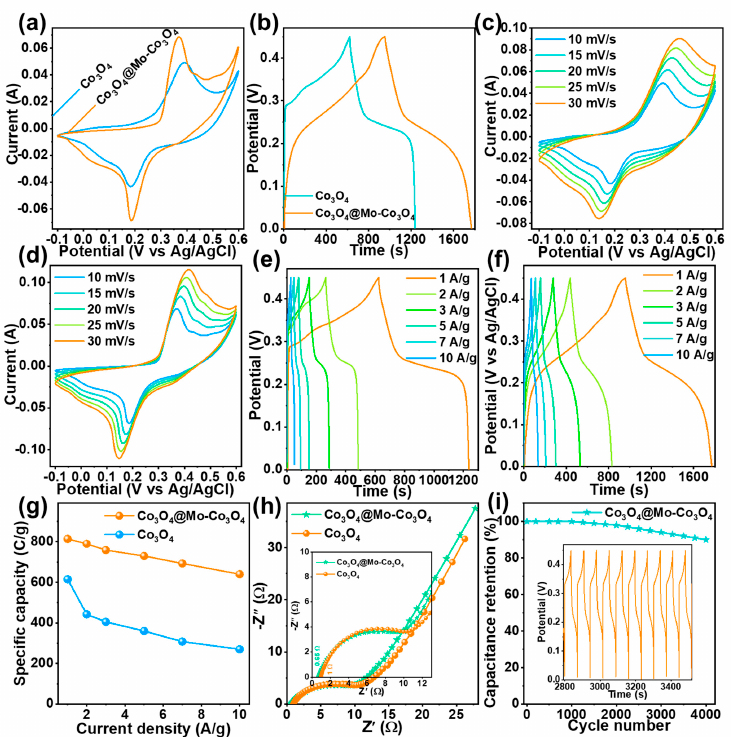
Figure 5. ( a , b ) Comparison plots of CV at 10 mV/s scan rate and GCD at 1 A/g current density for Co 3 O 4 and the Co 3 O 4 @Mo-Co 3 O 4 heterostructure, ( c , d ) CV curves at scan rates of 10–30 mV/s, ( e , f ) GCD curves at current densities of 1–10 A/g, ( g ) calculated specific capacity values from GCD curves, ( h ) Nyquist plot of Co 3 O 4 and the Co 3 O 4 @Mo-Co 3 O 4 heterostructure , ( i ) capacitance retention over 4000 GCD cycles; inset: ten consecutive GCD cycles.